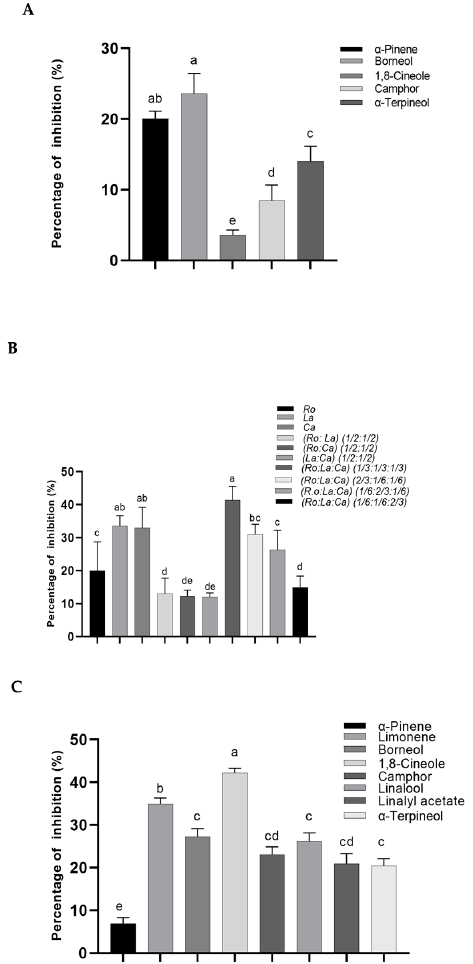
Figure 4. Enzymatic activities. ( A ) Percentage of lipoxygenase enzyme inhibition of the major components α -pinene (1 mg/mL), borneol (1 mg/mL), 1,8-cienole (1 mg/mL), camphor (1 mg/mL), α -terpineol (1 mg/mL); ( B ) Percentage of tyrosinase enzyme inhibition obtained from EOs of samples (4.0–4.6 mg/mL) extracted by hydrodistillation and simultaneous hydrodistillation–steam distillation; ( C ) Percentage of tyrosinase enzyme inhibition of the major components (50 mg/mL). Bars represent standard deviations (n = 3). Values with the same letter are not significantly different ( p > 0.05) by Tukey’s multiple range test.